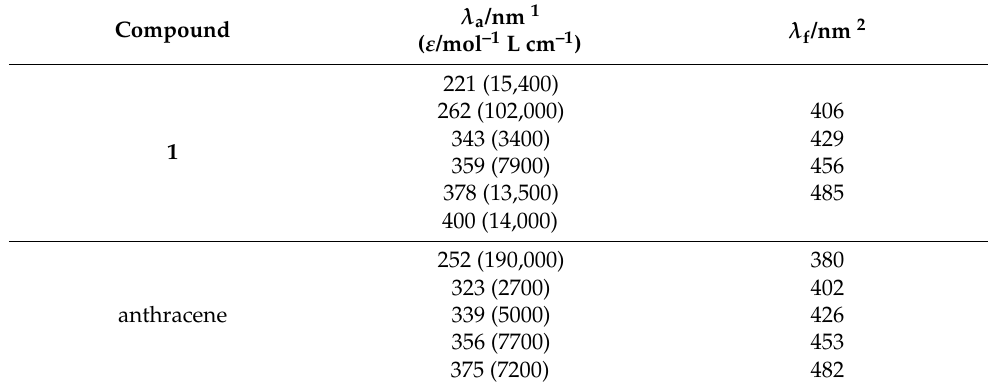
Figure 3. Fluorescence spectra of 1 and anthracene in 3-methylpentane at 77 K. The pale red ( 1 ) and blue (anthracene) bars denote fluorescence calculated by using the optimized structures of the S 1 states of 1 and anthracene at the TD-DFT B3LYP/6-31G(d) level. Table 1. Photophysical parameters of 1 and